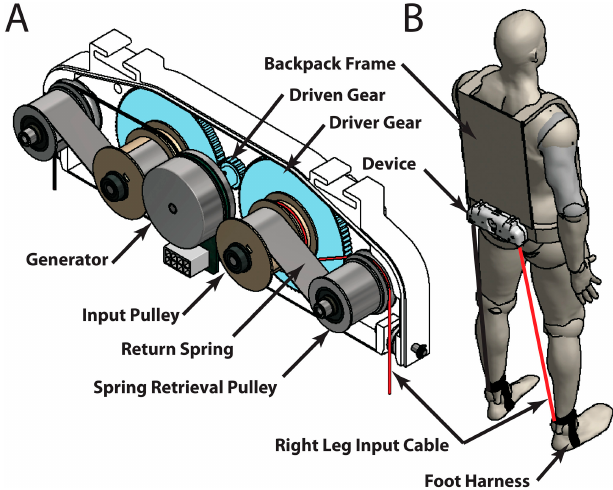
Figure 7. Lower-limb driven wearable energy harvesters [46]: ( A ) schematic of device components; ( B ) schematic view of the device worn by the user. Reproduced under a Creative Commons Attribution CC-BY 4.0 license.